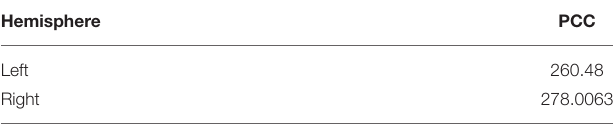
TABLE 1 | Inter-hemisphere FC with PCC.